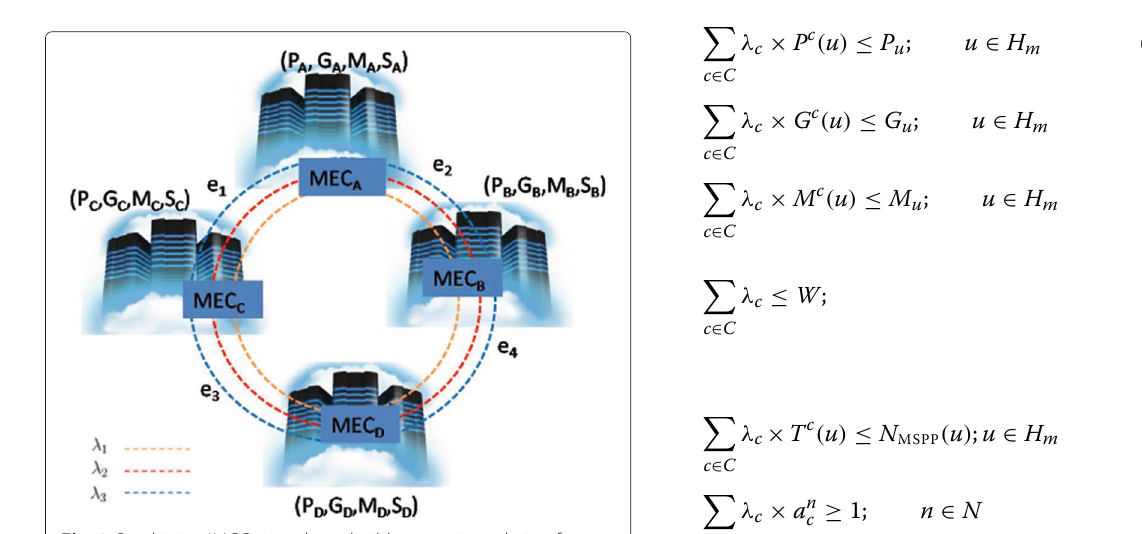
Fig. 3 Combining IMCCs in order to build a mapping solution for media cloud requests